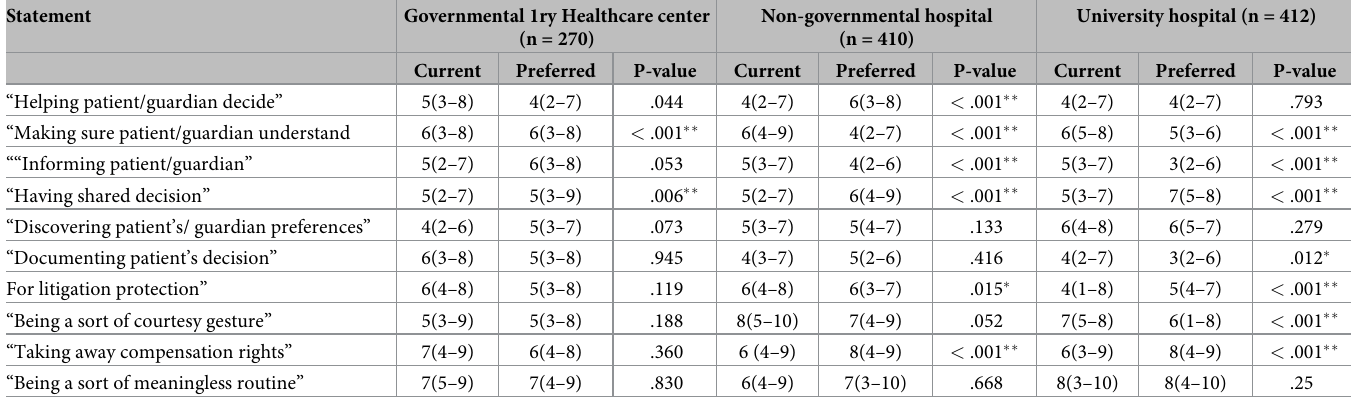
Table 4. Differences between patients’ perception of the current and preferred purposes of the IC practices within each of the study